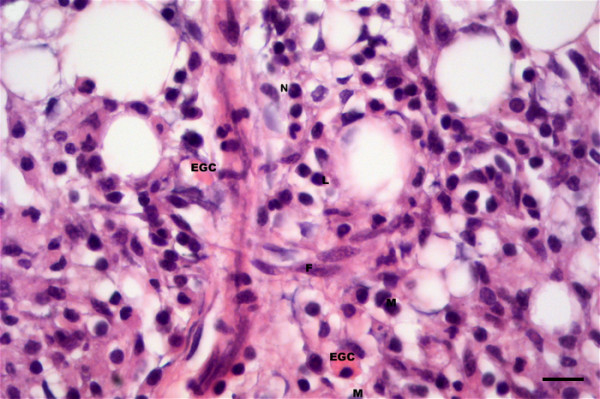
Mixed cell infiltrate at injection-site of Atlantic salmon at 12 weeks following injection. Cellular composition of inflammation consisting of macrophages (M), eosinophilic granular cells or mast cells (EGC), lymphocytes (L) and a few neutrophils (N). Fibroblasts are also distinct (F). Bar = 10 μm.